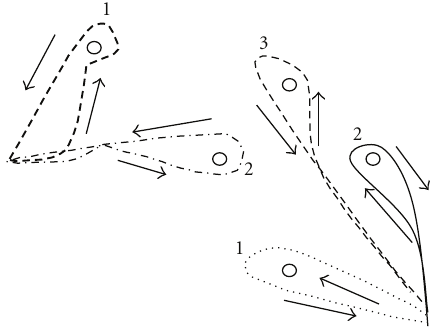
Figure 15: Di ff erent cases for the evasion controller evaluation.